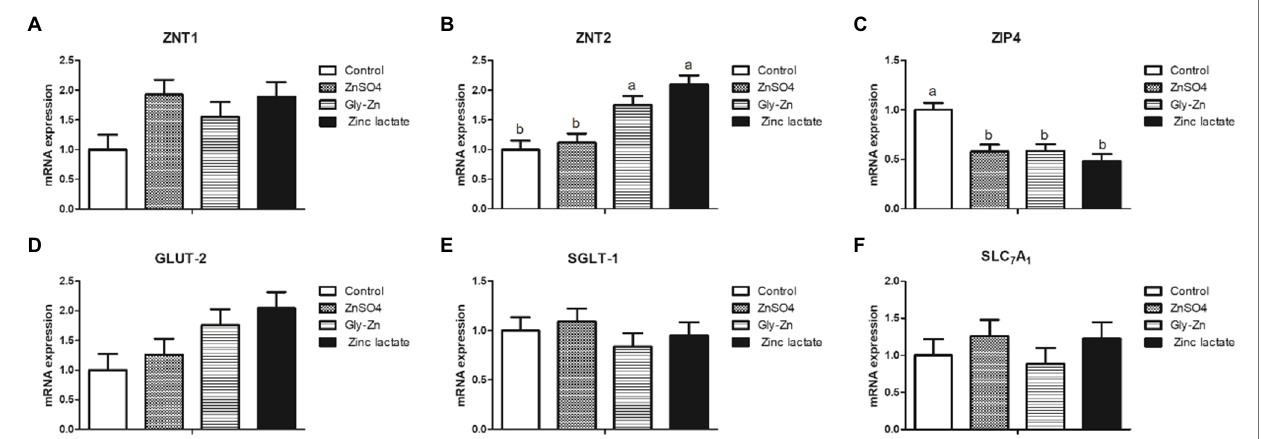
FIGURE 1 | Effect of dietary zinc sources on the relative mRNA expression levels of jejunal digestion- and absorption-related genes in weaned piglets. Control, basal diet. ZnSO4, basal diet +100 mg/kg zinc sulphate. Gly-Zn, basal diet +100 mg/kg glycine zinc. Zinc lactate, basal diet +100 mg/kg zinc lactate. The relative mRNA expression levels of jejunal zinc transporter 1 (ZNT1; A) , zinc transporter 2 (ZNT2; B) , ZRT/IRT-like protein 4 (ZIP4; C) , glucose transporter type 2 (GLUT-2; D) , sodium/glucose cotransporter 1 (SGLT-1; E) , and solute carrier family 7 (SLC 7 A 1 ; F) were determined by real-time quantitative PCR. a,b Within a row, means without a common superscript letter differ ( p < 0.05).